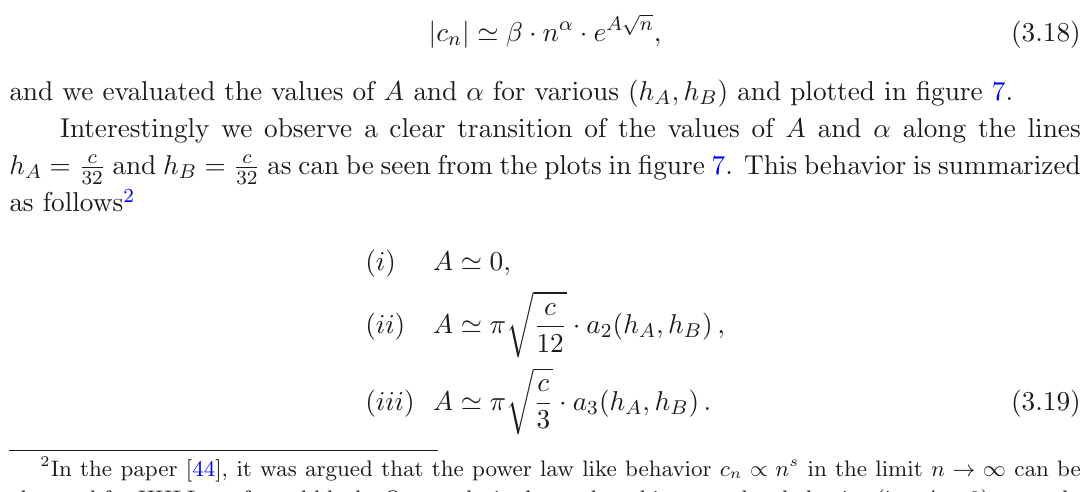
i.e. the region (i), where c n grows 240